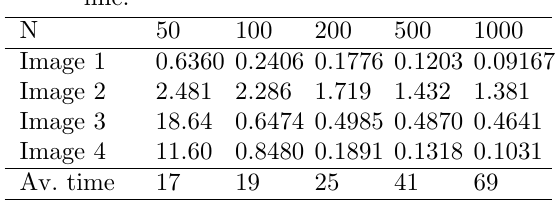
Table 3: Standard deviation in degrees for each of the 4 test images as a function of the number of hypotheses for vanishing points. The average computation time in ms is shown in the last line.